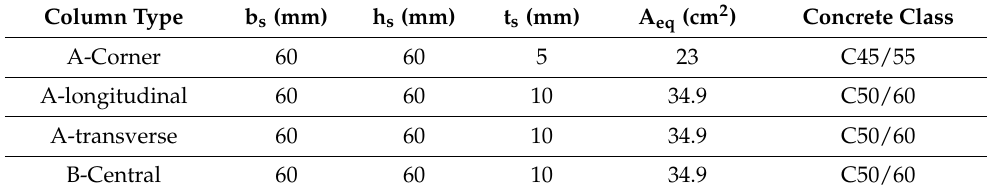
Table 6. Local intervention technique with steel angles and batten plates—first hypothesis.